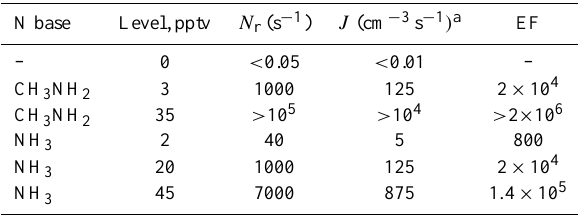
Table 4. Ammonia and amine addition experiments at